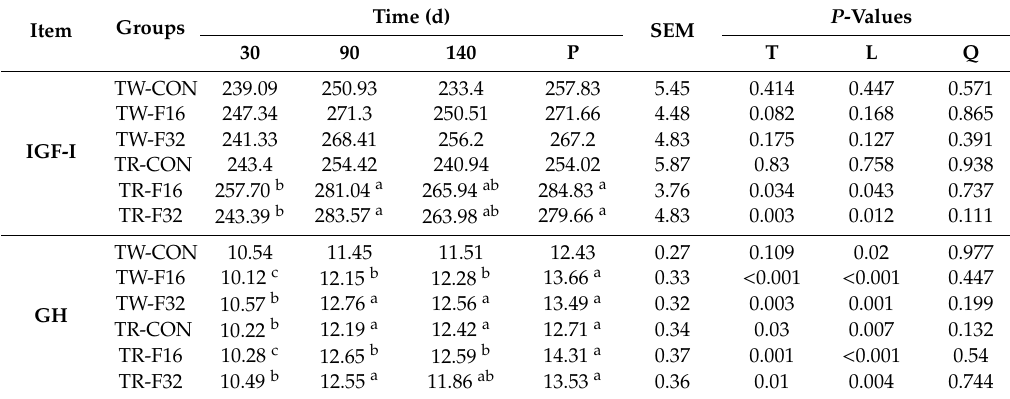
Table 4. The change of IGF-I and GH in serum over time of pregnancy (ng /